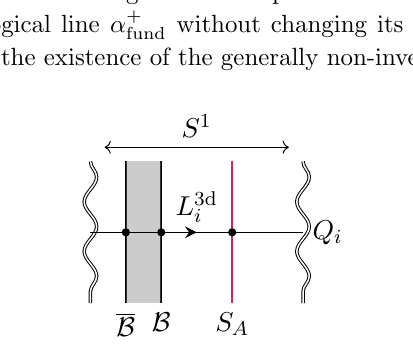
Figure 6. 1+1d adjoint QCD from coupled 2+1d systems on S 1 . The left wiggly line and the right wiggly line are identi(cid:12)ed. The white region is (cid:12)lled with the SU( N ) N CS theory, while the gray region is (cid:12)lled with the SU( N ) 0 Yang-Mills theory with (cid:12)nite YM coupling without CS term. In the CS theory region we have the topological surface operator S A . On the interfaces B and B between these theories, left- and right-moving fermions reside. To obtain the 1+1d adjoint QCD, we take the limit where the width of the gray region becomes zero. The one-form symmetry generator Q 1 in 1+1d adjoint QCD is realized by the topological line operator L 3d one-form symmetry wrapping S 1 . In the CS region, L 3d (cid:22) = (0 ; : : : ; 0 ; N